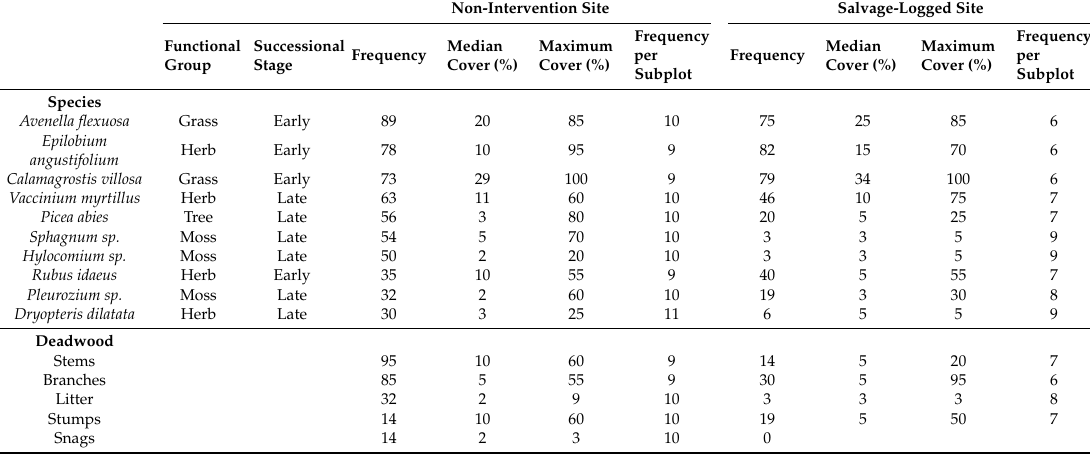
Table 1. The frequency, the cover of plant species and deadwood categories, for subplots in non-intervention (NI) ( n = 108) and salvage-logged (SL) ( n = 95) sites are presented. Although all deadwood categories are included, species that occurred on 30 or more subplots of the NI site are shown. Values for all species are included in the Supplementary